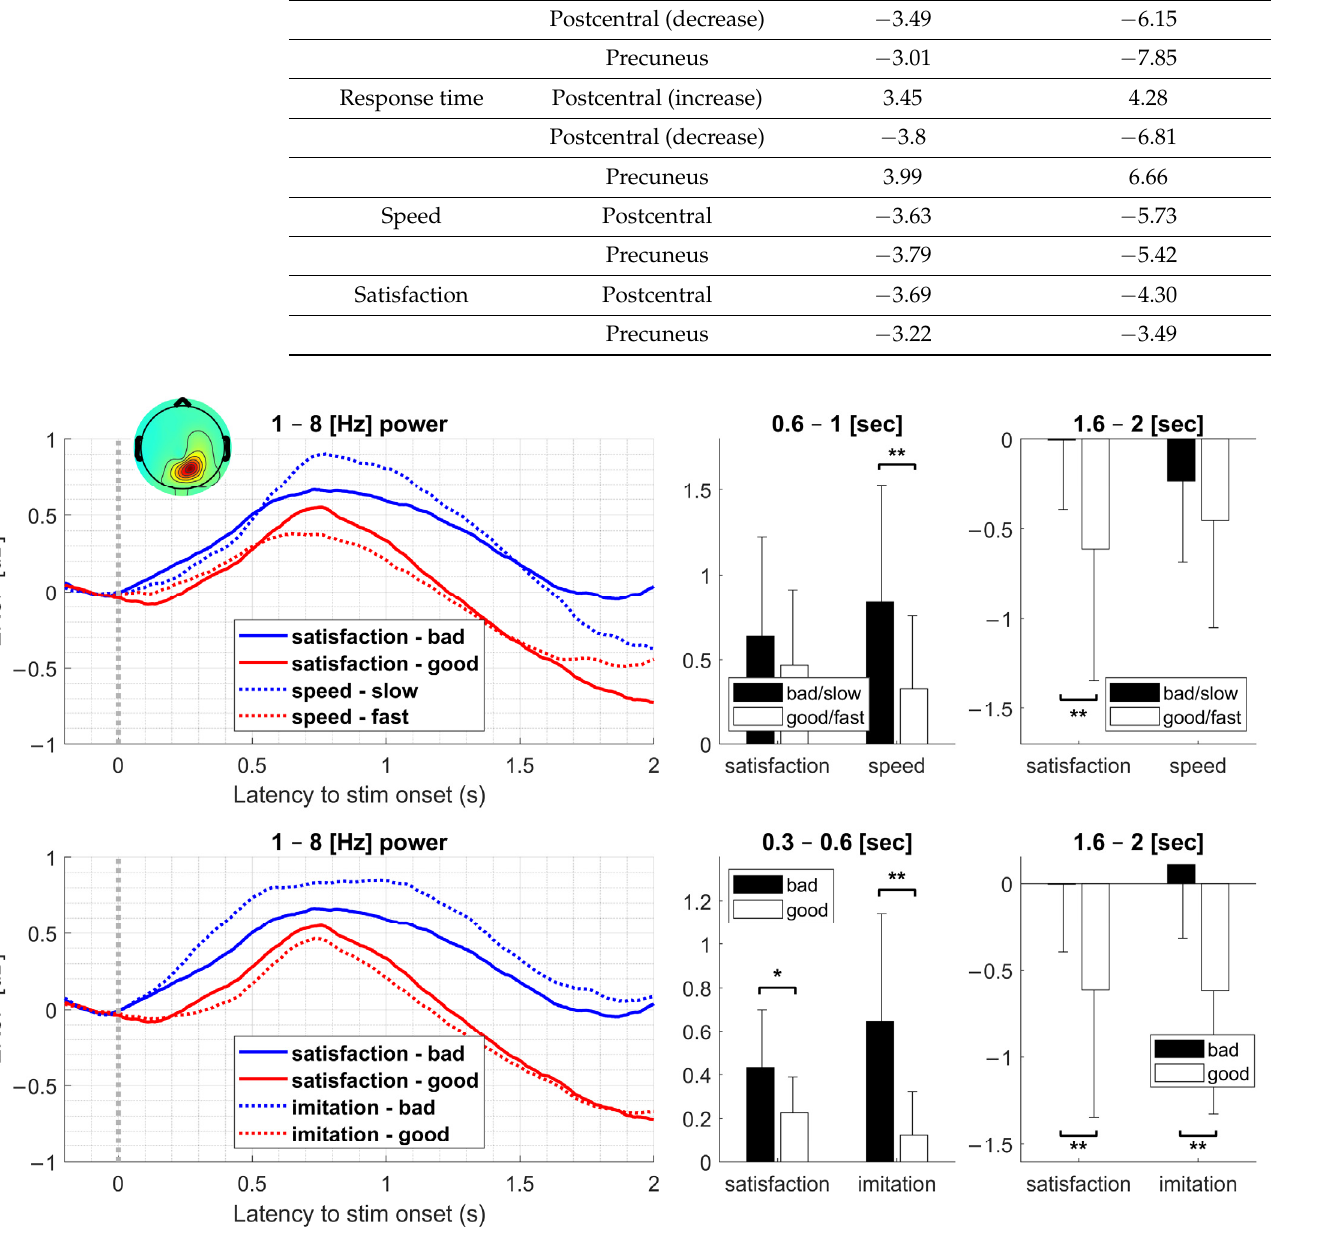
Figure 5. Power (1–8 Hz) of the clusters related to the precuneus. We extracted powers within the range of 1–8 Hz shown as a significant area in ERSP. The comparison of the movement speed exhibited a power difference within the range of 0.6–1 s, although the power difference in satisfaction was not significant. Although the power difference within the range of 1.6–2 s was significant in the comparison of satisfaction and imitation, the difference in the movement speed was not. Within the range of 0.3–0.6 s, satisfaction exhibited a moderate difference, and imitation exhibited a more significant difference. All tests were performed by t -test (*: p < 0.05; **: p <